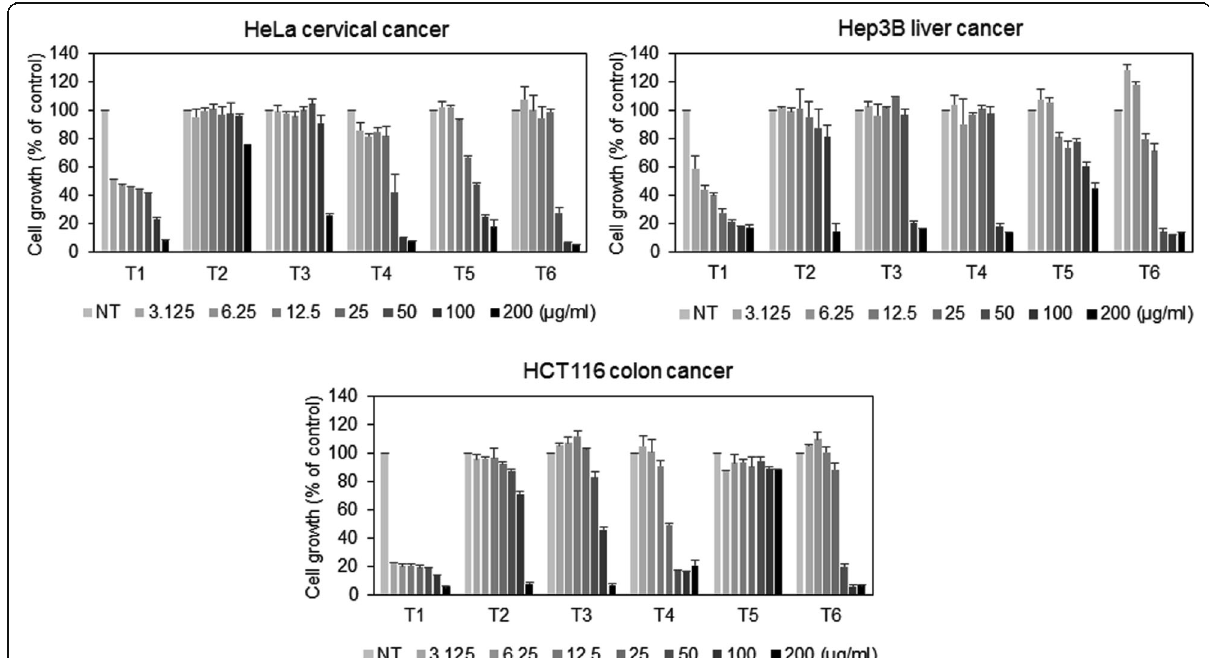
Fig. 2 Antiproliferative effects of plant extract against cancer cells (MTT